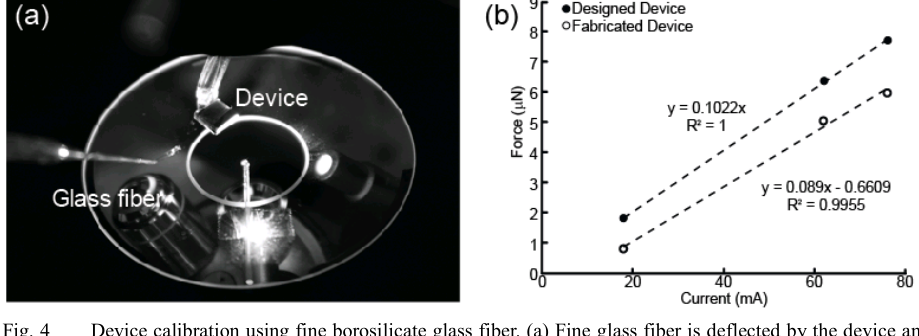
Device calibration using fine borosilicate glass fiber. (a) Fine glass fiber is deflected by the device and the force applied to the glass fiber is calculated by using a fixed-free beam equation. (b) Graph of device calibration. ● indicate calculated relationship between the applied current and the force. ○ indicate actual measurement relationship between the applied current and measured force which is converted from measurement of glass tip